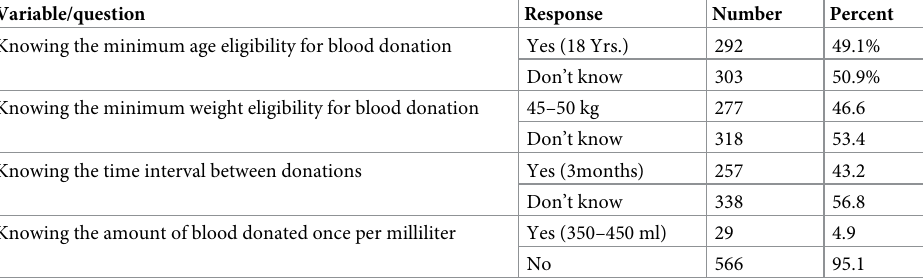
Table 2. Respondents knowledge on voluntary blood donation among students attending private colleges in Jimma town, Oromia, Ethiopia.